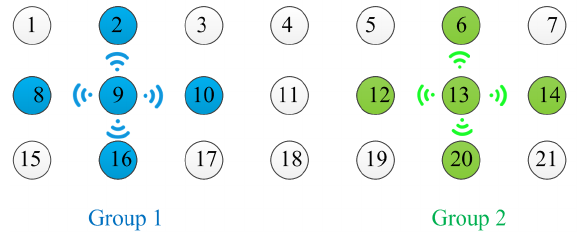
Figure 3. Demonstration of two groups of antennas performing local calibration simultaneously. These two groups are colored with blue and green. The central antennas (antenna 9 and 13) need to keep m -hops away from each other to nullify mutual